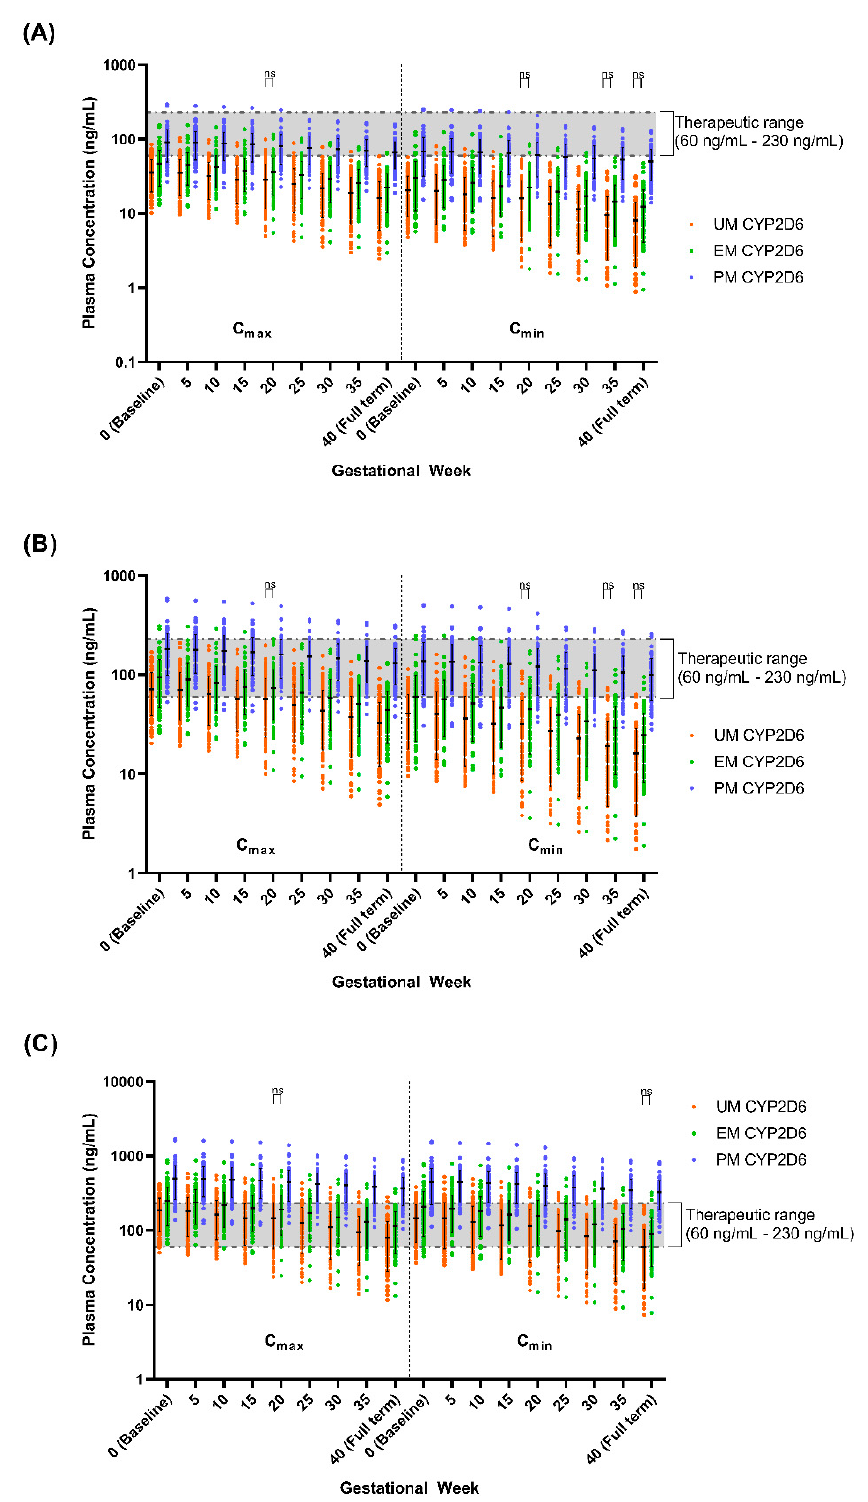
Figure 10. Simulated fluvoxamine maternal concentrations in CYP2D6 phenotype population. ( A ) 50 mg daily; ( B ) 100 mg daily; ( C ) 300 mg daily. Coloured solid circles represent individual, predicted maternal concentrations. C max , maximum concentration; C min , minimum concentration. Horizontal lines on the coloured solid circles represent mean and standard deviations. The shaded region represents the fluvoxamine TW. Comparison between each CYP2D6 phenotype for every 5 GWs showed statistically significant difference except between UM and EM at GW labelled as ‘ns’, p >